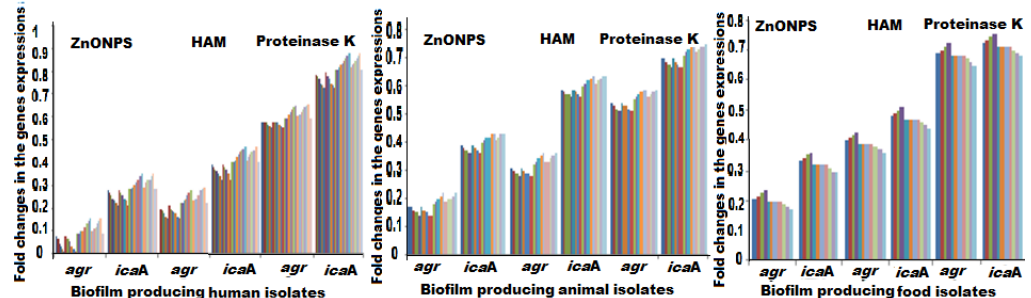
Figure 3. Fold changes in the expression of ica A and agr genes for all biofilm producing isolates post exposure to ZnO NPs, HAM, and proteinase K. agr : accessory gene regulator; ica A: intercellular adhesion A gene; ZnO NPs: zinc oxide nanoparticles; HAM: